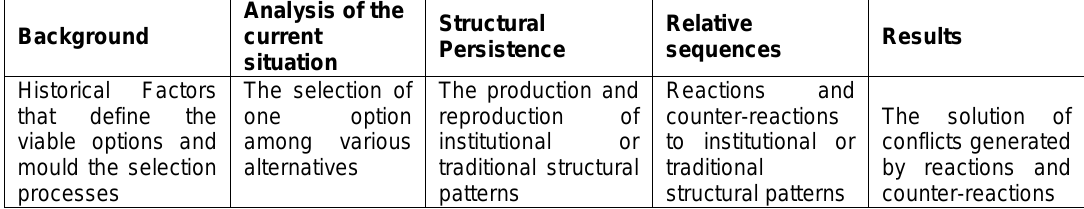
Table 1 . Analytical structure of path dependence